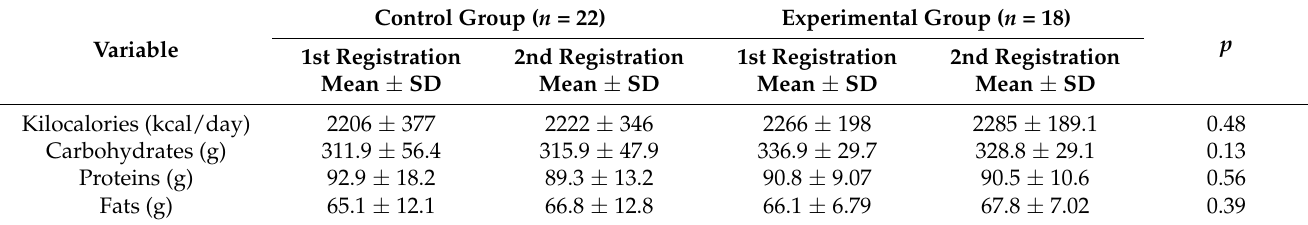
Table 2. Average macronutrient and energy intake.